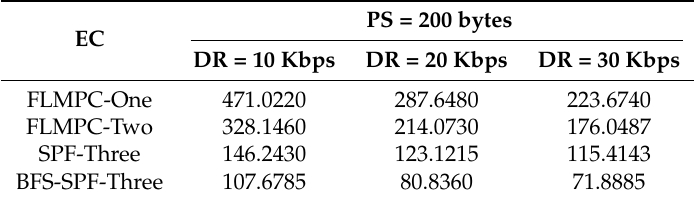
Table 6. EC Values with PS of 200 bytes.